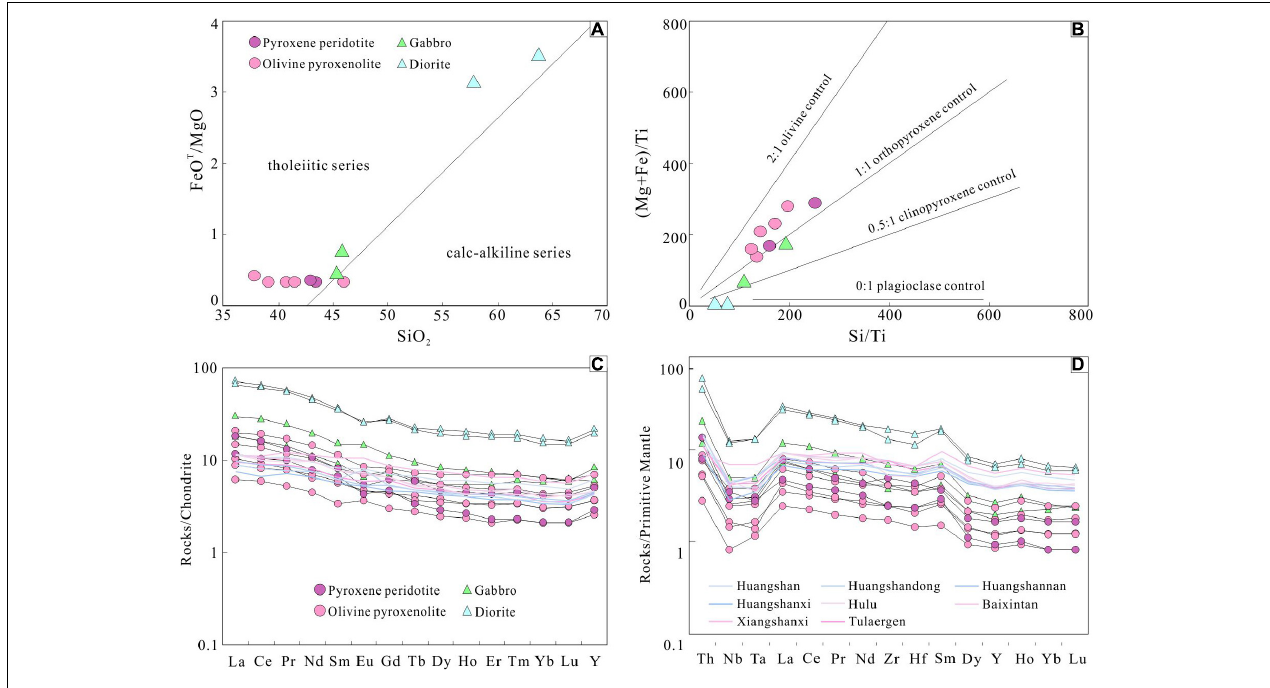
FIGURE 6 | Geochemical diagram of Lubei intrusion. Plot of SiO 2 versus FeO T / MgO (A) and (Mg+Fe)/Ti versus Si/Ti (B) . chondrite– normalized REE patterns (C) and primitive mantle normalized trace element patterns (D) of the Lubei intrusion. The average data of line symbols are from Supplementary Appendix 1 . Chondrite normalizing values are from Taylor and Mclennan (1985). Primitive mantle normalizing values are from Sun and McDonough